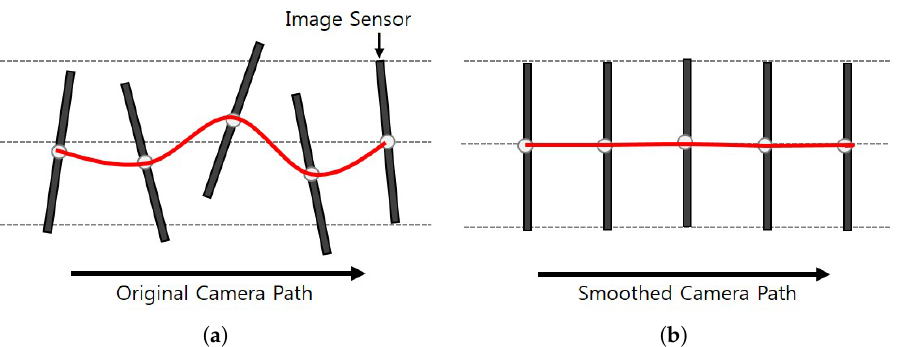
Figure 1. Video acquisition process using a complementary metal oxide semiconductor (CMOS) sensor portable camera: ( a ) input shaky camera path and ( b ) the smoothed camera